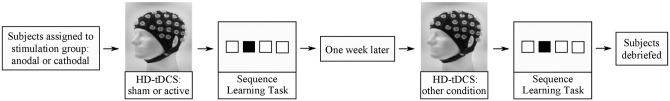
Overview of experimental procedure.HD-tDCS image source: Soterix Medical.